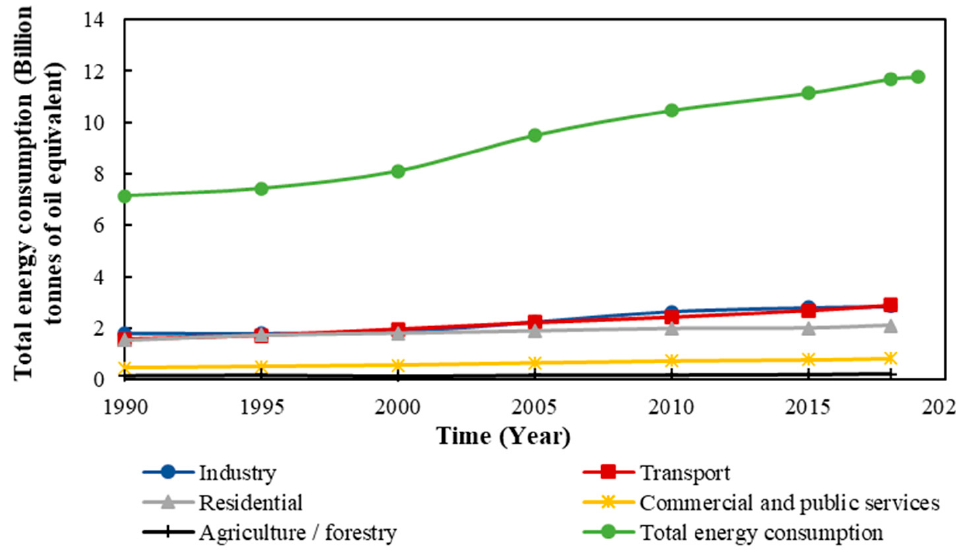
Figure 1. World’s total energy consumption by sector over the period between 1990 and 2019 [1,2].